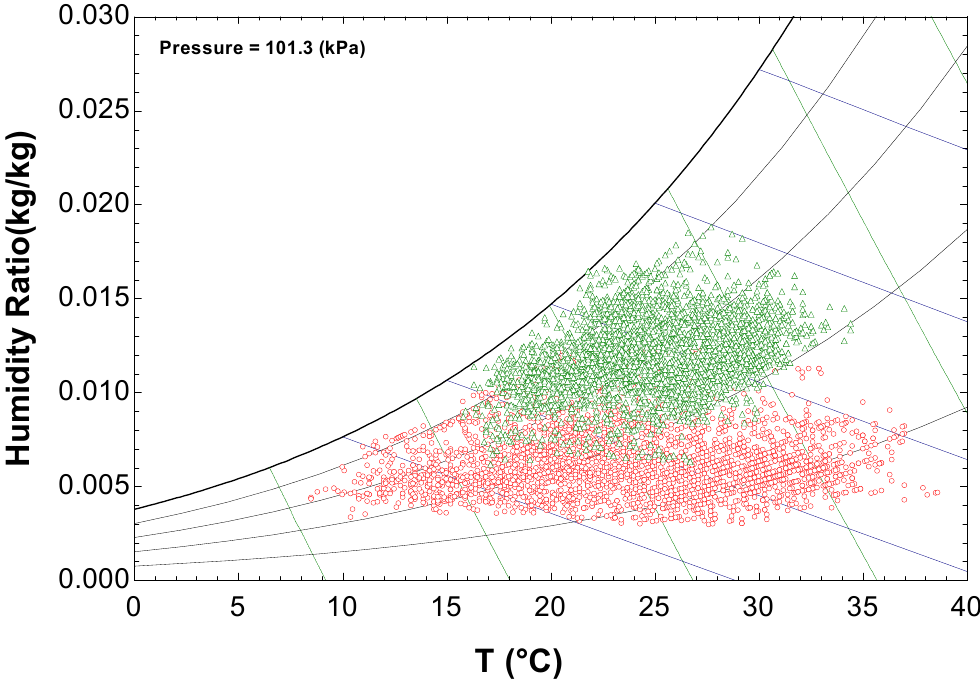
Figure 4. Weather conditions on an hourly basis for the summer season (June–September) in Madrid (red dots) and Elche (green triangles).